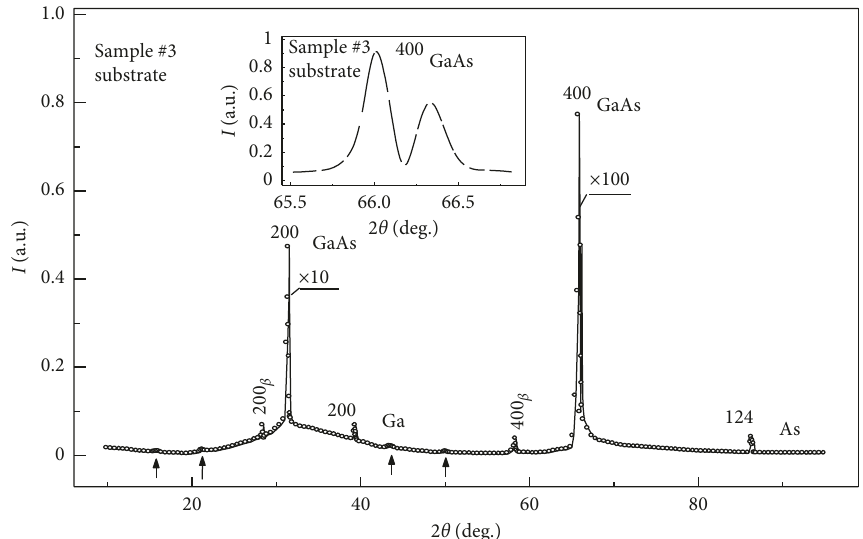
Figure 5: The X-ray diffraction pattern of the GaAs